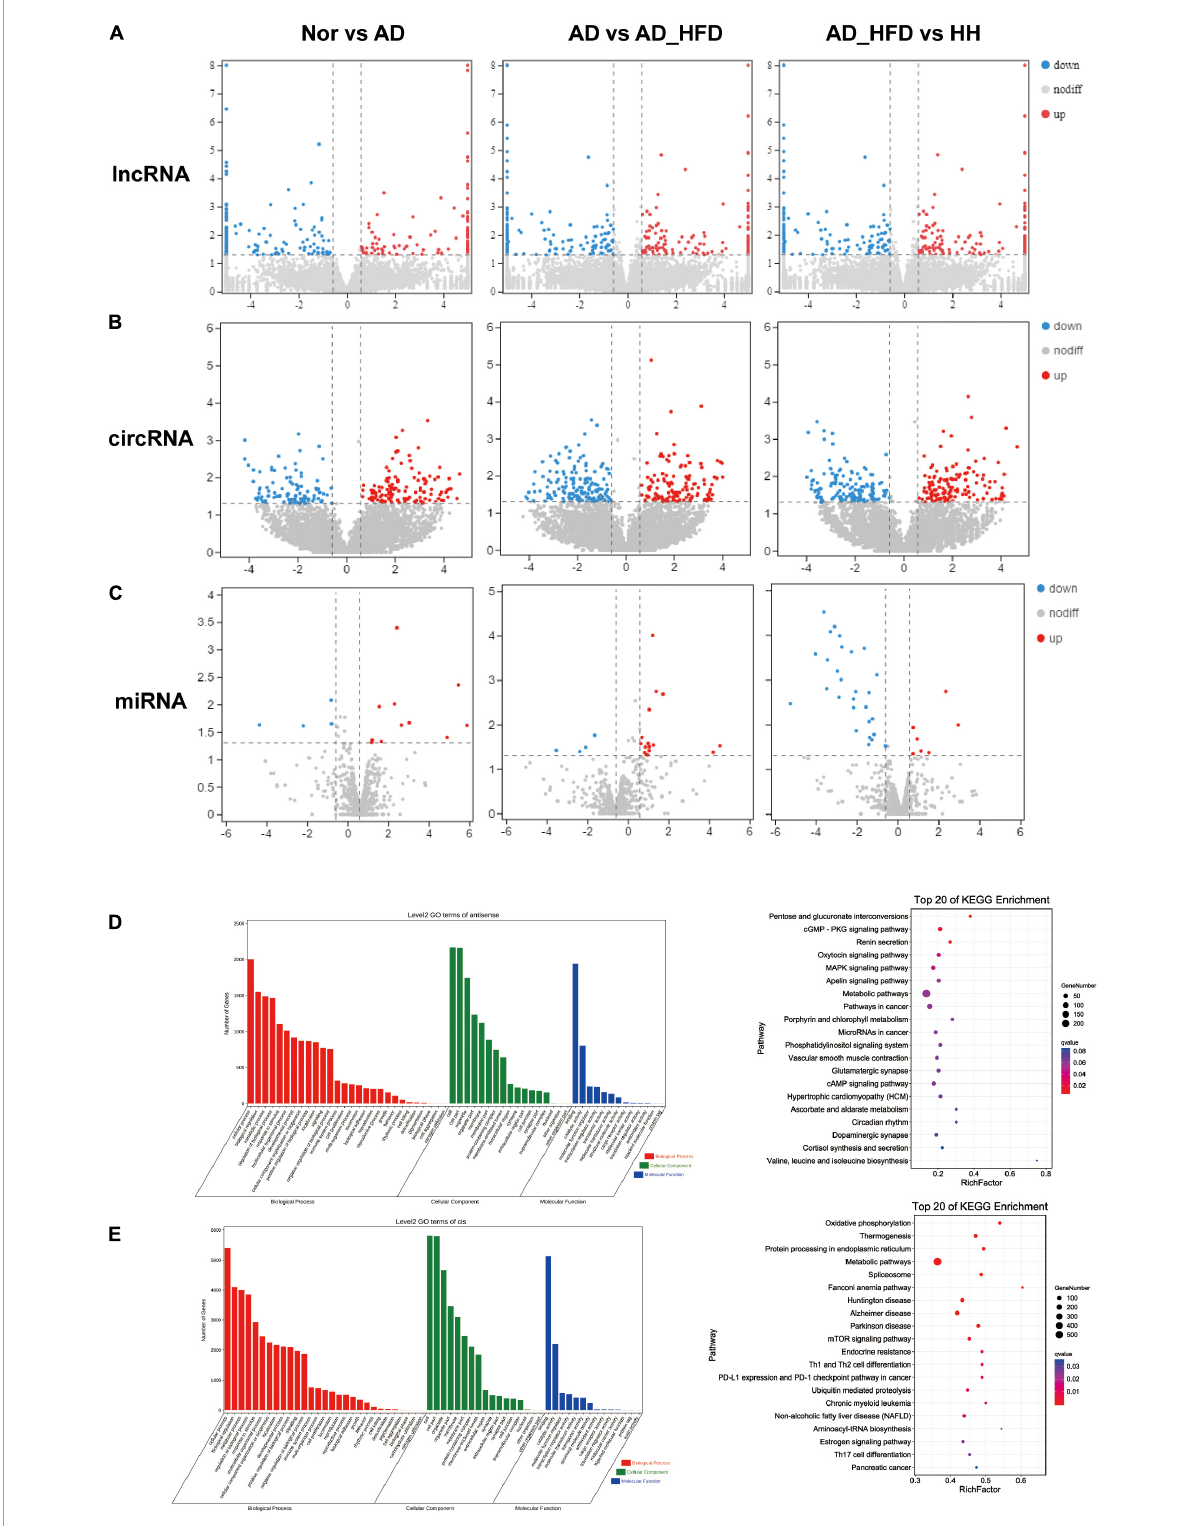
FIGURE5 No coding RNAs sequence analysis. Differentially expressed genes heatmaps of lncRNA-seq (A) , circRNA-seq (B) , and miRNA-seq (C) . GO and KEGG enrichment analysis of antisense gene (D) and cis gene (E) .